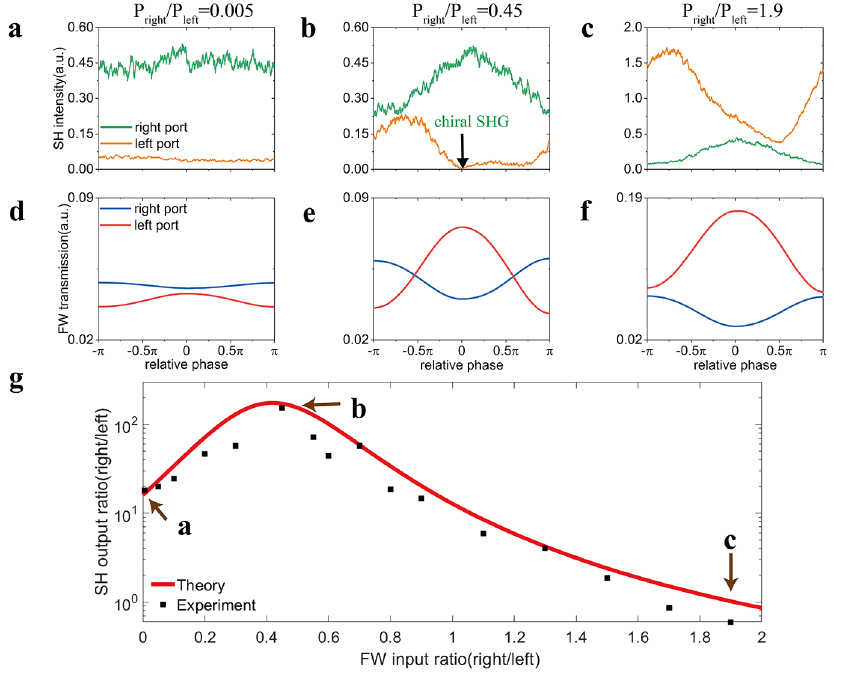
Fig. 5 Chiral second harmonic generation through coherent control. Three typical phase-controllable SHG with different input power ratios between right and left ports are shown in ( a ) to ( c ), with their corresponding fun- damental waves’ output from the two ports ( d ) to ( f ). All of the results are measured at the zero-detuning point ( ∆ 1 = 0 ). The perfect annihilation of left SHG occurs in ( b ), when the two fundamental wave inputs are in- phase ( e ). Such distinction ratio of SHG outputs from both ports are plotted against the fundamental wave input ratio between the right and left in ( g ), which shows an optimal point with a maximal distinction ratio of ~ 153 at P right / P left = 0 . 45 . The power of the left-input beam is fixed at 1mW while varying the right one to change the input power